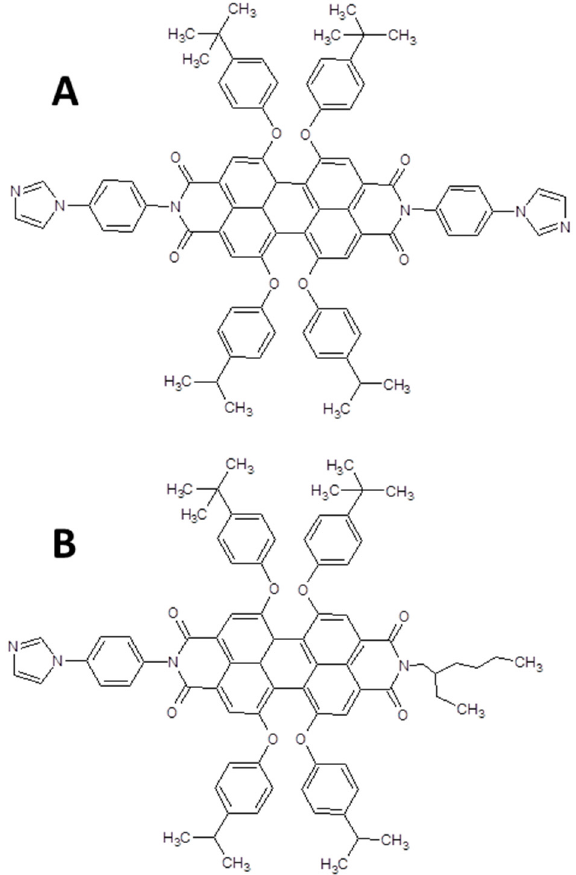
Figure 6. Chemical structures of the bis-( A ) and mono ( B ) substituted PDIs used to form the supramolecular adducts with the ZnPc reported in the reference [72].